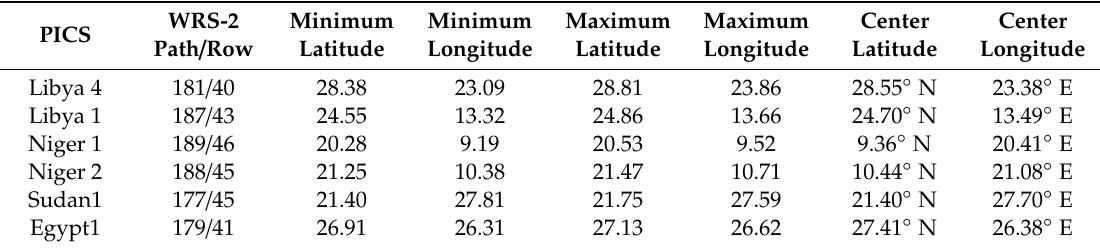
Table 3. WRS-2 Path / Row and Center ROI coordinates of selected